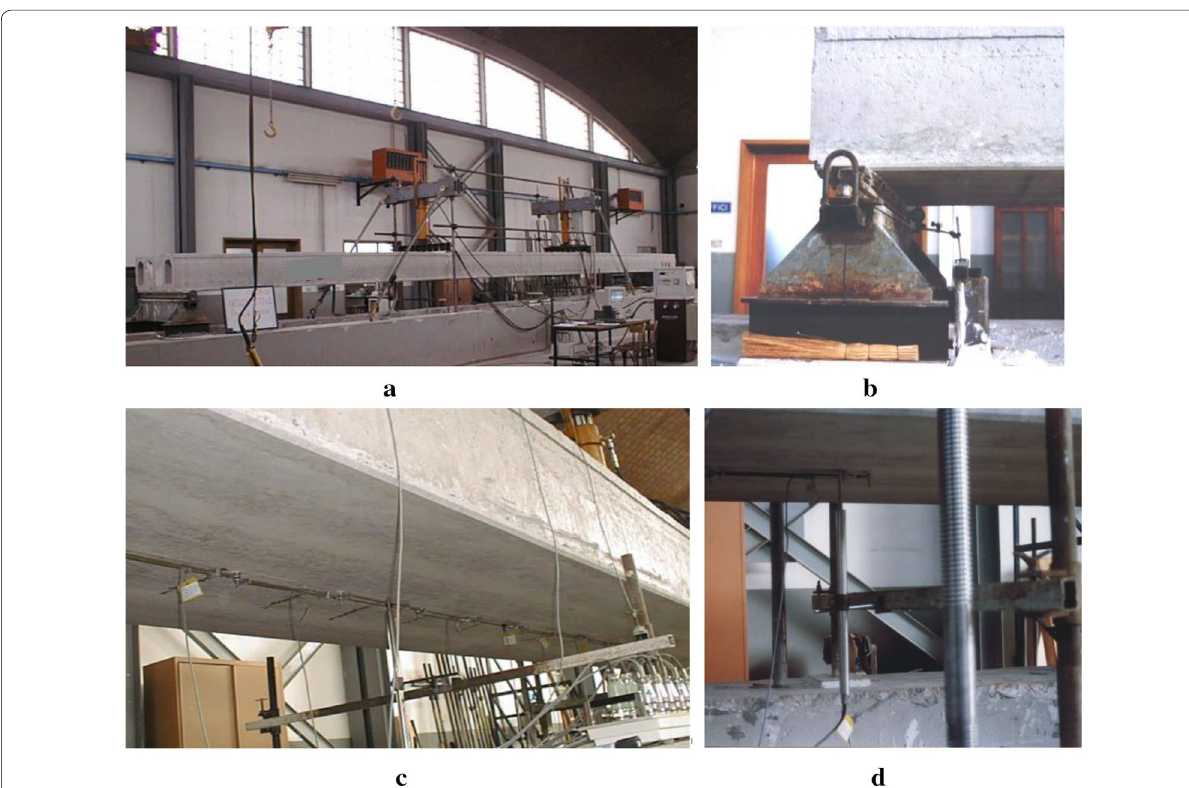
Fig. 3 Flexural tests on specimens H50-f1 and H50-f2: a general view of the specimen during the test; details of the adopted experimental setup: b steel support at specimen end; c LVDTs at the bottom surface of HCS; d LVDT for the measurement of vertical displacements.